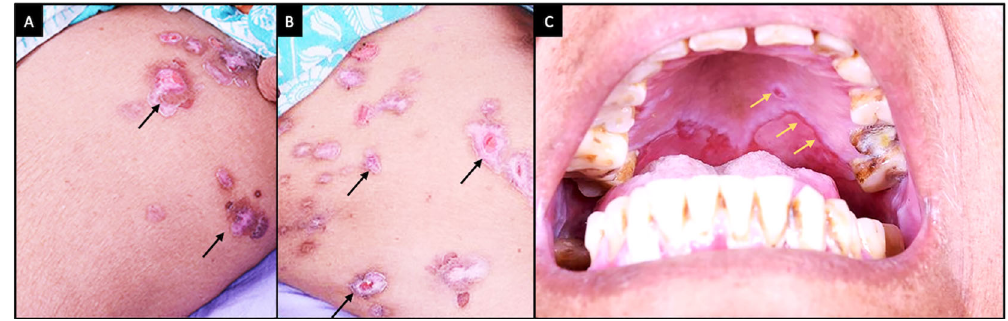
Figure 5. Systemic clinical features at presentation of case 3. (A, B) Ruptured blisters over the flexor aspect of the thighs (black arrows). (C) Oral ulcers over the hard and soft palate (yellow arrows).